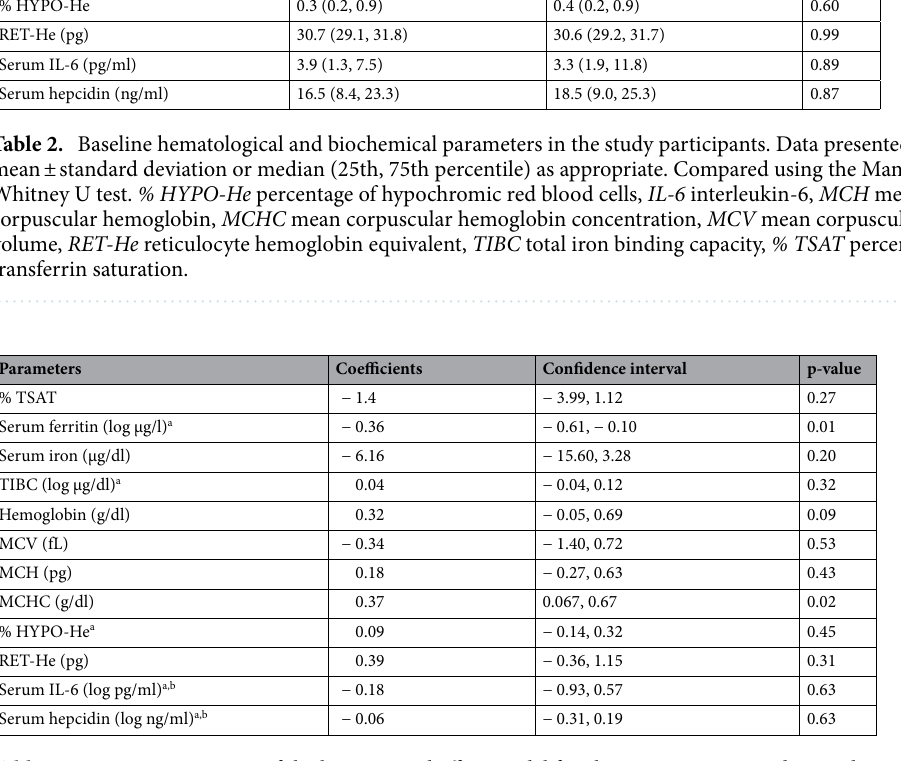
Table 3. Parameter estimates of the linear mixed effect model for change in primary and secondary parameters between OD versus BD group. Compared using the linear mixed effect model, BD group